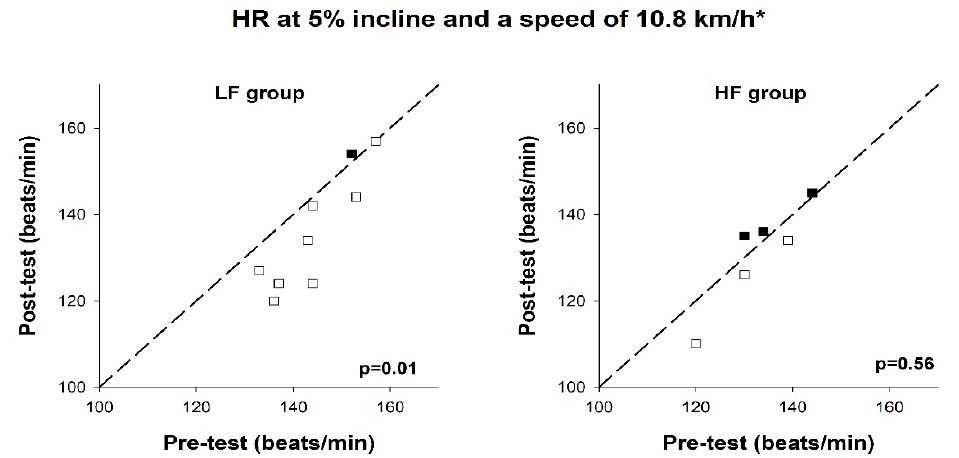
Figure 6. Heart rate at a speed of 10.8 km / h at pre- and post-test, in the low-frequency group (LF group) and high-frequency group (HF group). Reference lines indicate identical values at pre- and post-test. Each box represents a test subject. Open boxes indicate an improvement and filled boxes indicate a decline, compared to the pre-test. * = 9.0 km / h for women.